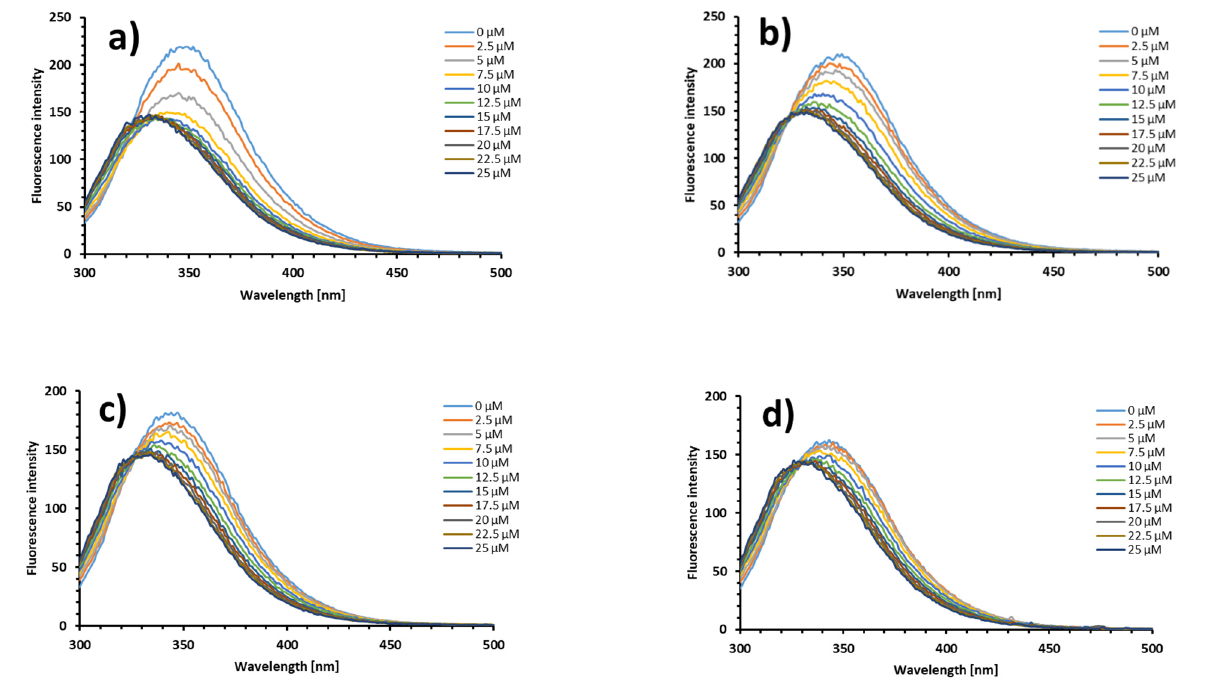
Figure 5. The fluorescence emission spectra of free BSA ( a ) and the solutions of BSA with Na[B(Ph) 4 ] mixed in molar ratios 1:3 ( b ); 1:7 ( c ); and 1:15 ( d ) in the presence of increasing concentrations of SDS (0–25 µ M) in the 10 mM Caco buffer of pH 7.0 at 298.15 K.